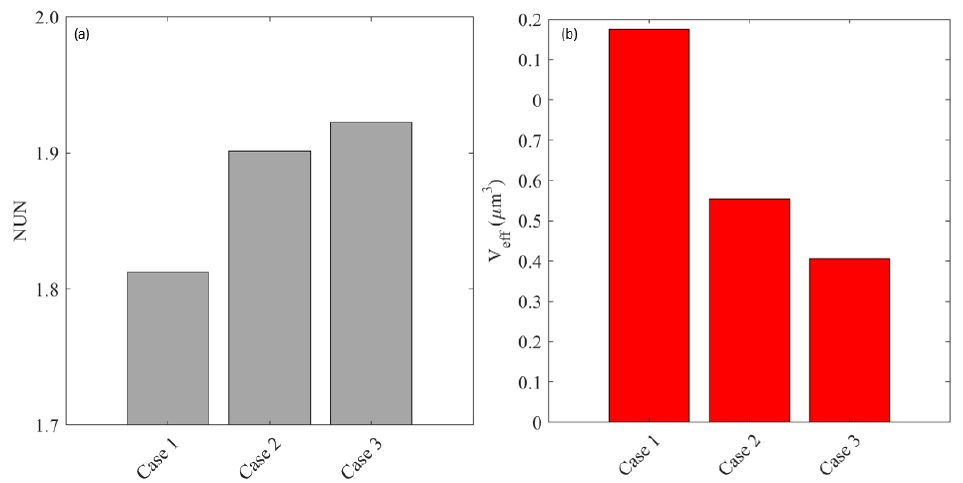
Figure A9. Impacts of cell volume fraction of infusion site on ( a ) drug distribution, and ( b ) treatment effectiveness in the brain tumor. The results are taken on Day 3.